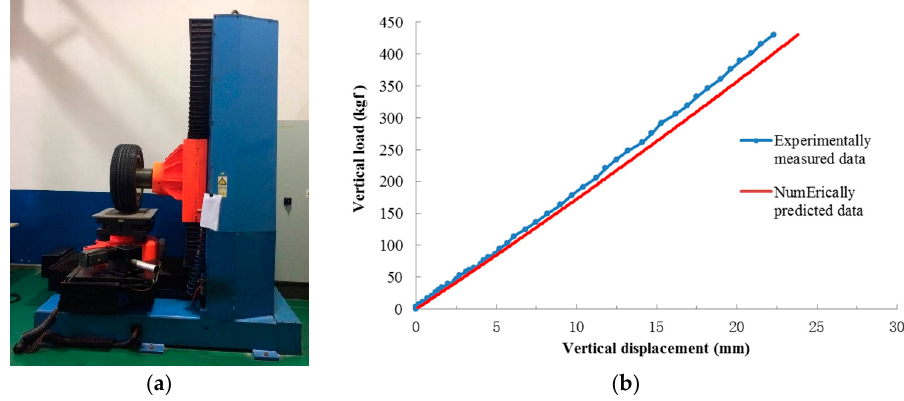
Figure 5. Verification of simulation model against experimental data on tire static test. ( a ) Tire static loaded test; ( b ) Load-tire vertical deformation comparison of numerically simulated results and experiment measurements. Table 4. Contact area comparison of the numerically simulated results and experiment measurements.